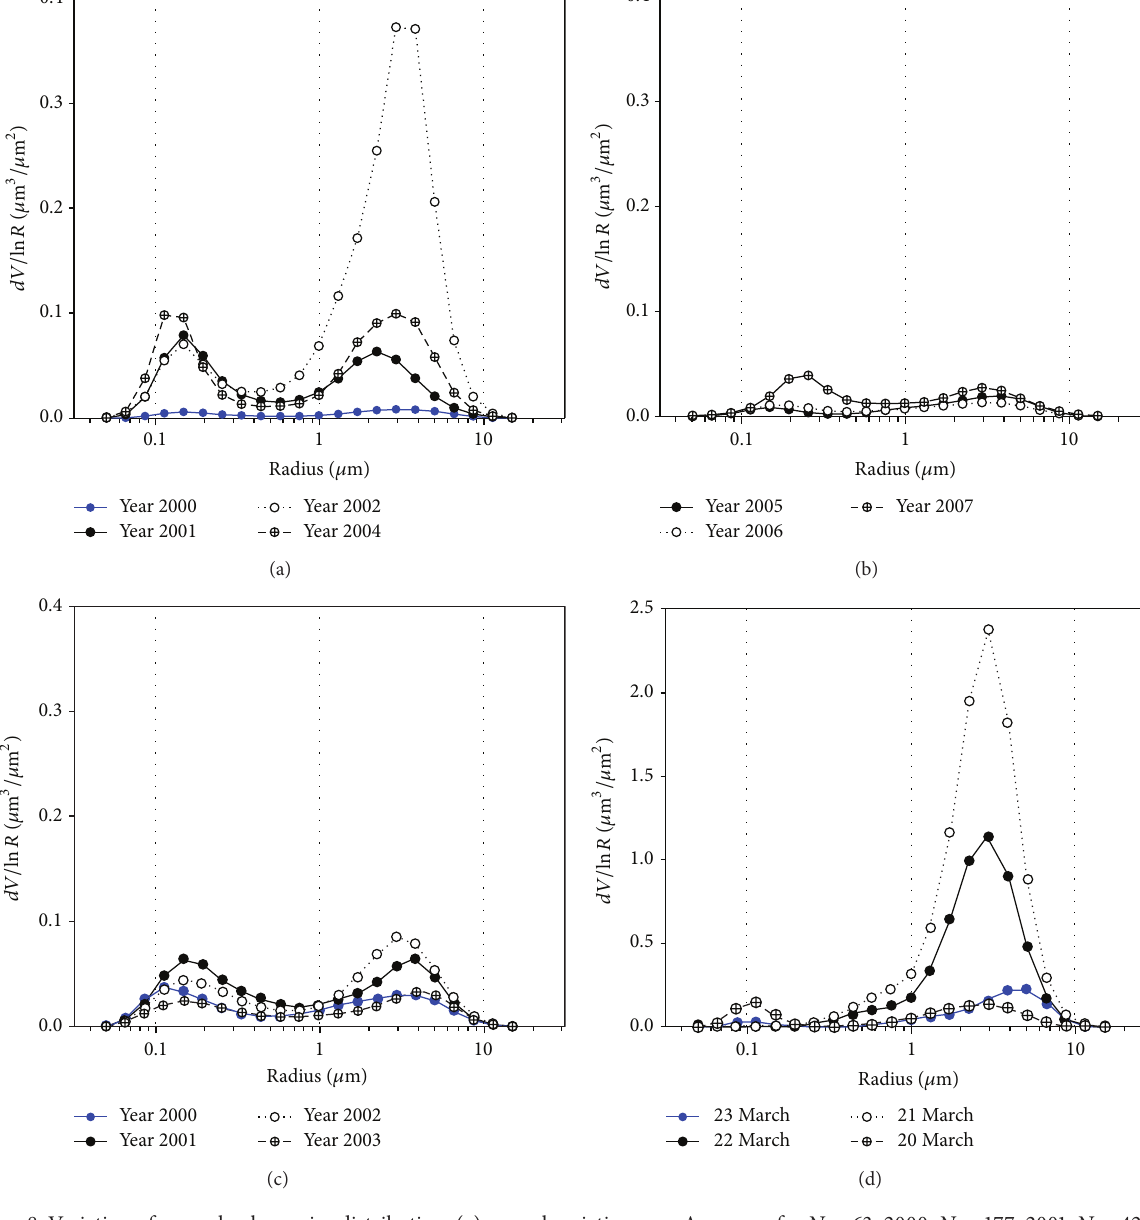
Figure 8: Variation of aerosol volume size distribution: (a) annual variation over Anmyeon for 𝑁 = 63 , 2000, 𝑁 = 177 , 2001, 𝑁 = 42 , 2002, and 𝑁 = 209 , 2004, (b) over Anmyeon for 𝑁 = 117 , 2005, 𝑁 = 174 , 2006, and 𝑁 = 189 , 2007, (c) over Seoul from for 𝑁 = 15 , 2000, 𝑁 = 8 , 2001, 𝑁 = 106 , 2002, and 𝑁 = 14 , 2003, and (d) daily variation over Seoul before, during, and after the dust storm of 21 March 2002. 𝑁 is the number of days